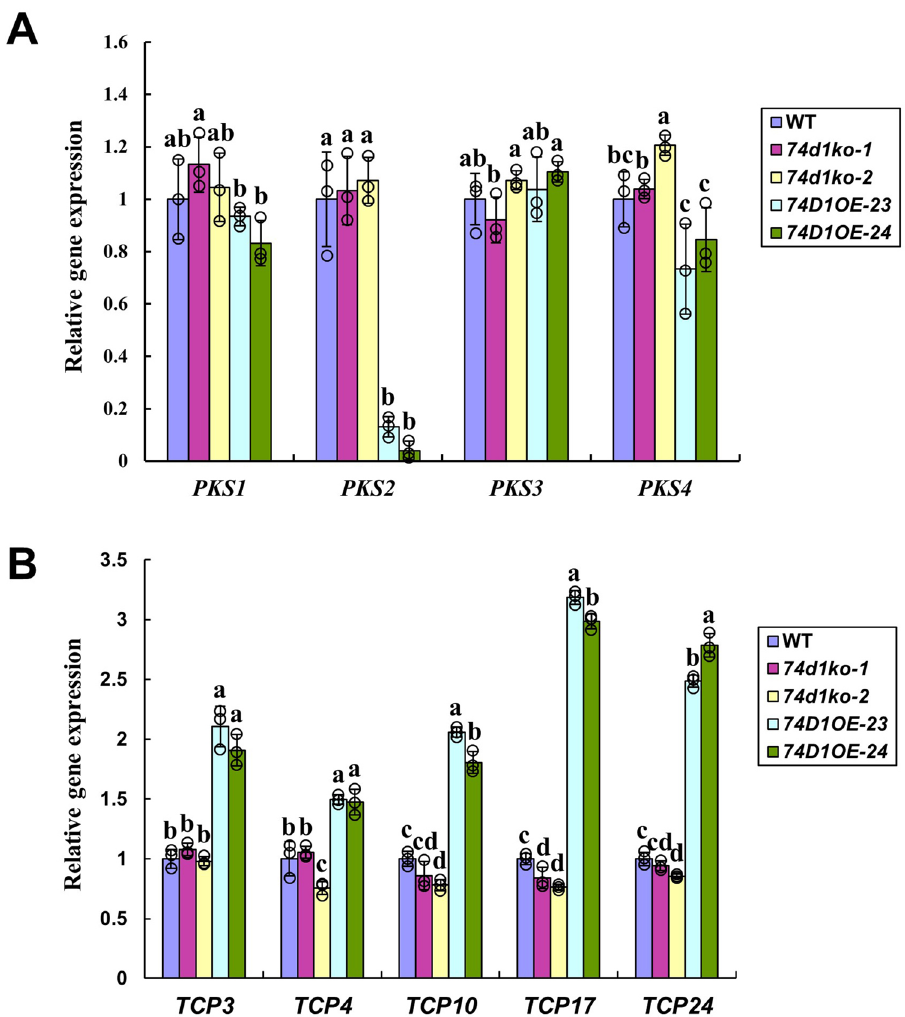
Figure 8. Altered expression level of leaf shape related genes. ( A ) Transcript level of PKS gene family. ( B ) Transcript level of TCP gene family. The relative transcript level was normalized to the transcript abundance of Actin 2 gene. The statistical significance of the difference was confirmed by ANOVA at α = 0.05 level. Error bars indicate SD from triplicate